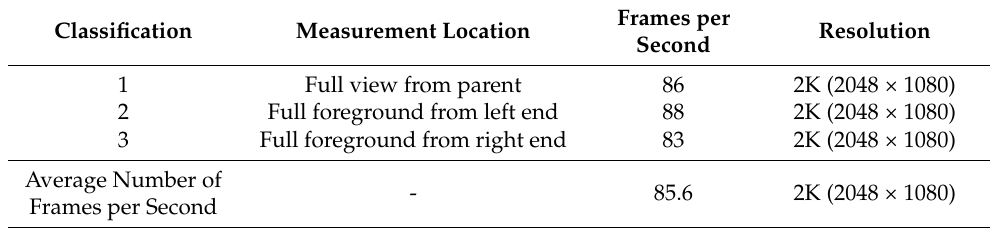
Table 6. Frame count and resolution per